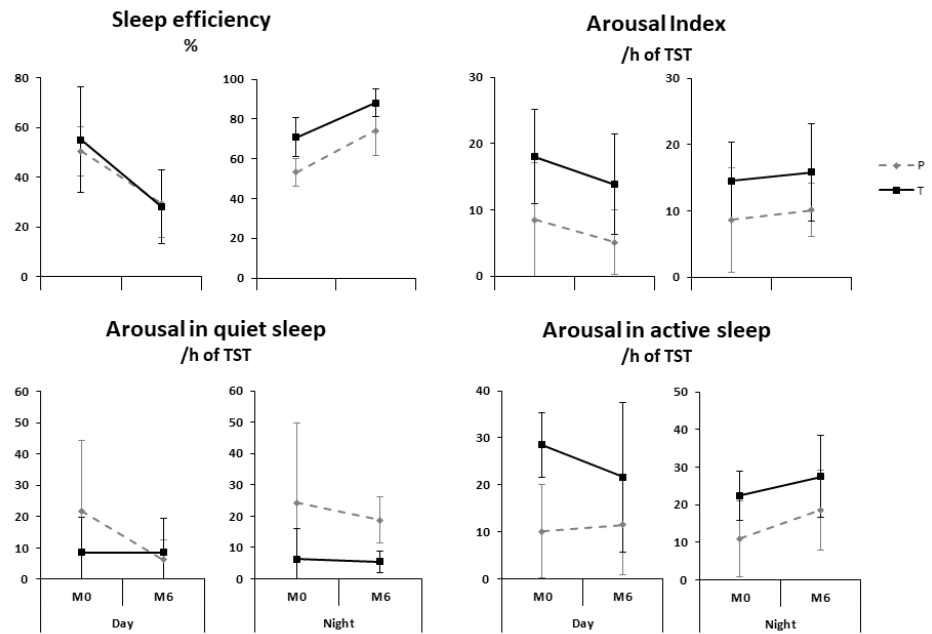
Figure 2. Sleep efficiency and arousal maturation during day and night sleep in preterm (dotted lines) and term (solid lines) infants.